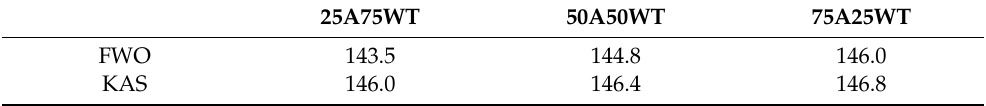
Table 4. The calculated activation energy of the blends 25A75WT, 50A50WT, and